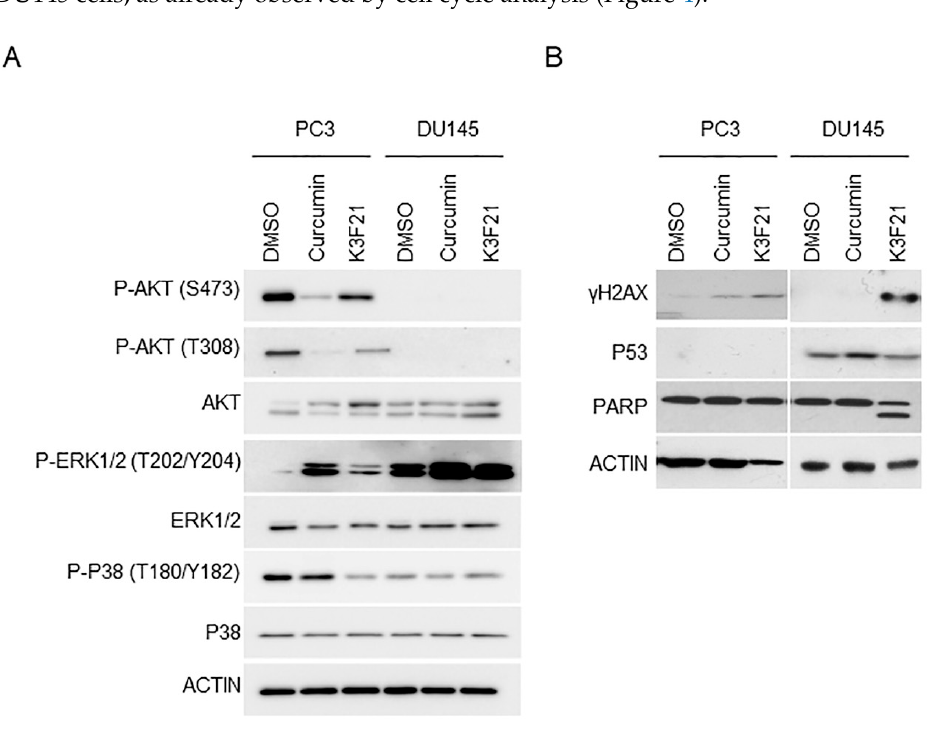
Figure 6. Effects of K3F21 on PCa promoting pathways. Total cellular lysates from PC3 and DU145 cells treated